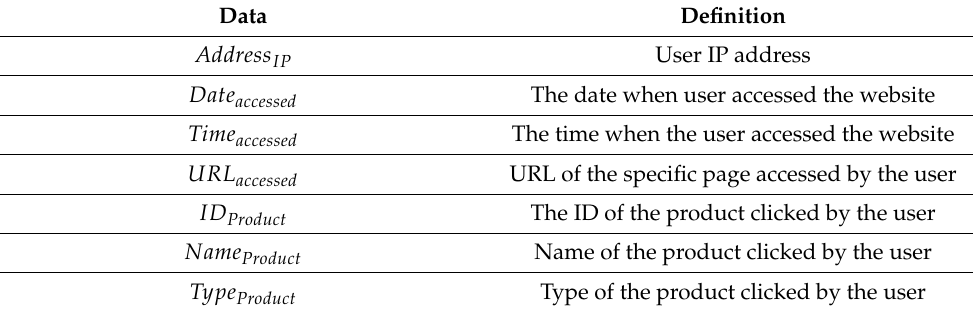
Table 2. Description of data.